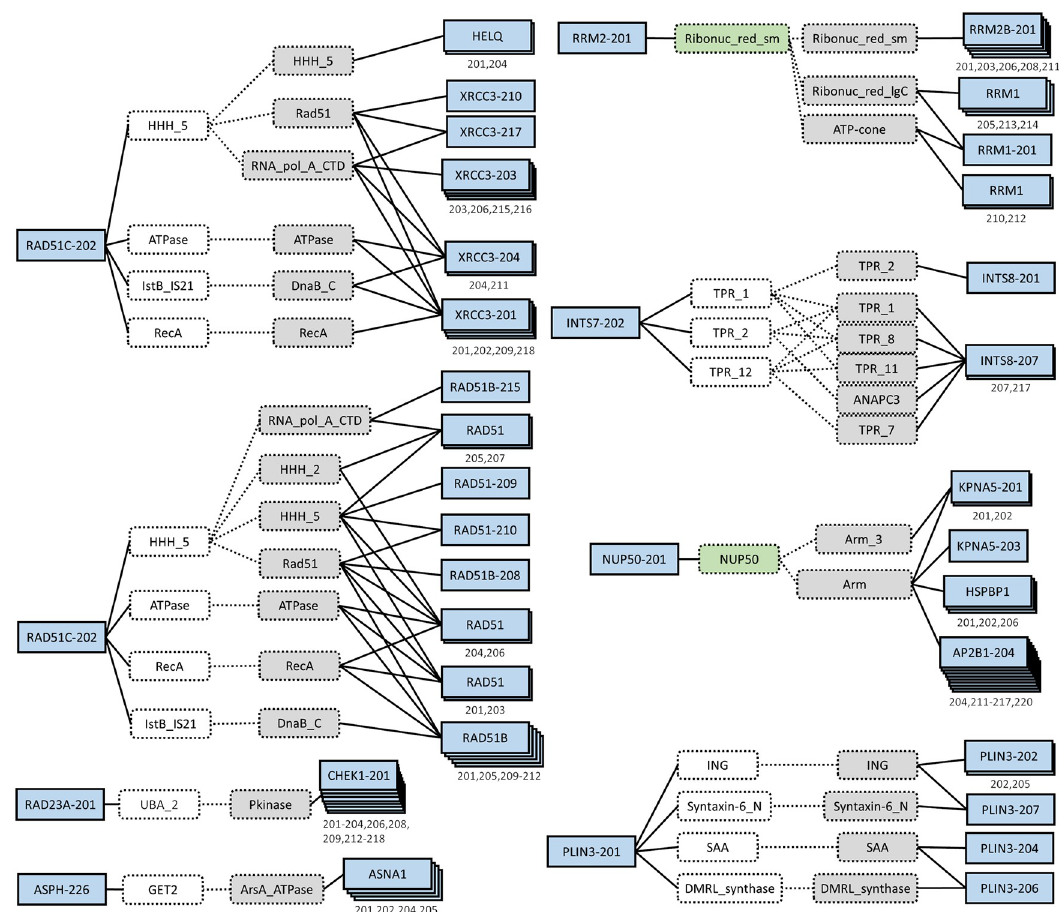
Fig 3. Multi-granularity graphs. Splice variants are in blue solid boxes and domains are in dotted boxes. The significant splice variant (left box) is linked to its gained (green) and ghost (white) domains. Domains in gray belong to the non-significant splice variant (right box). Splice variants of the same gene that have identical domain connections in the MGG are stacked and their identifiers are listed below the boxes. RAD51C-202 has two MGGs which are separated to simplify visualization.